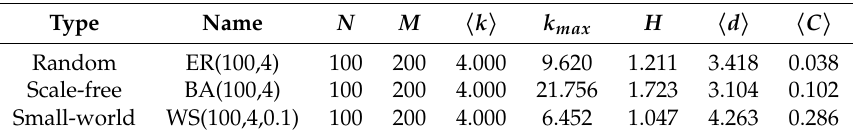
Table 2. Basic topological features of three synthetic networks. N and M represent the number of nodes and edges. (cid:104) k (cid:105) and k max are the average degree and the maximum degree. H is the degree heterogeneity. (cid:104) d (cid:105) denotes the average path length between node pairs. (cid:104) C (cid:105) is the average local clustering coefficient of the network. All features are averaged over 500 times of simulations on the corresponding synthetic